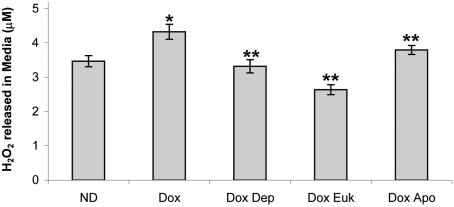
Elevation in astrocytic MAO-B results in increased extracellular hydrogen peroxide (H2O2).Extracellular H2O2 concentrations were measured in media isolated from uninduced (ND) versus dox-induced (Dox) mesencephalic cultures in the absence and presence of 10 µM deprenyl (Dox Dep), 30 µM EUK189 (Dox Euk) or 500 nM apocynin (Dox Apo) using the Amplex Red assay. H2O2 concentrations were quantified against a standard H2O2 curve. Measurements were made on three separate media aliquots harvested prior to immunostaining of cultures; *p<0.01 compared to ND, ** p<0.05 compared to ND.